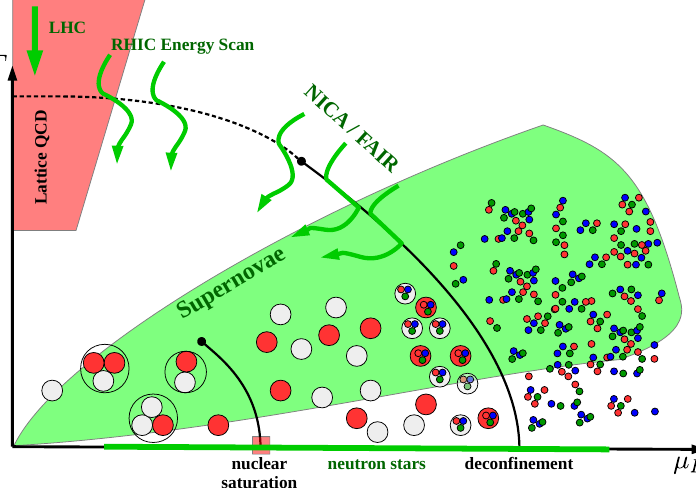
Figure 1. Schematic phase diagram of strongly interacting matter with the solid lines indicating first order liquid-gas and hadronic-quark matter phase transitions ending in dots symbolizing the critical endpoints. While for the nuclear liquid-gas phase transition the critical point is at a temperature of T LG c = 16.6 0.9 MeV [1], the position of the critical endpoint of the deconfinement transition is not ± known. The dashed line indicates the pseudocritical temperature T c ( µ B ) of the crossover transition from hadronic to quark matter which has been determined at vanishing baryochemical potential µ B = 0 in lattice QCD simulations to T c ( 0 ) = 154 9 MeV [2]. The red and white colored circles ± stand for neutrons and protons which at low densities can form nuclear clusters that get dissociated in the liquid phase. Similar to that case, nucleons themselves can be viewed as clusters of quarks symbolized by colored dots that get dissociated in the quark matter phase. The green shaded area is the domain of the phase diagram accessible by supernova explosions. The red shaded area is the region accessible by ab-initio simulations of QCD at finite temperatures and chemical potentials on space-time lattices. The green arrowed lines symbolize trajectories of heavy-ion collisions at different center of mass energies ranging form LHC over RHIC to the planned NICA/FAIR experiments. The green line on the chemical potential axis depicts the range of values accessible in compact star interiors. In this case, the third dimension of the charge (or isospin) chemical potential relevant for isospin asymmetric systems in supernovae, compact stars and their mergers is